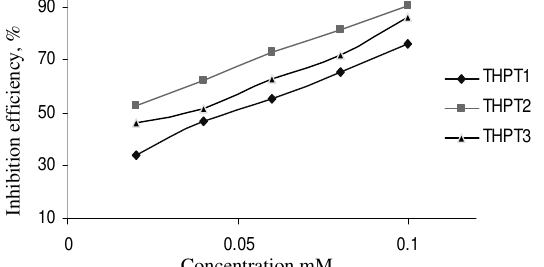
Figure 1. Plot of inhibition efficiency (%) vs concentration (mM) for the inhibition of corrosion of mild steel in 1 M H